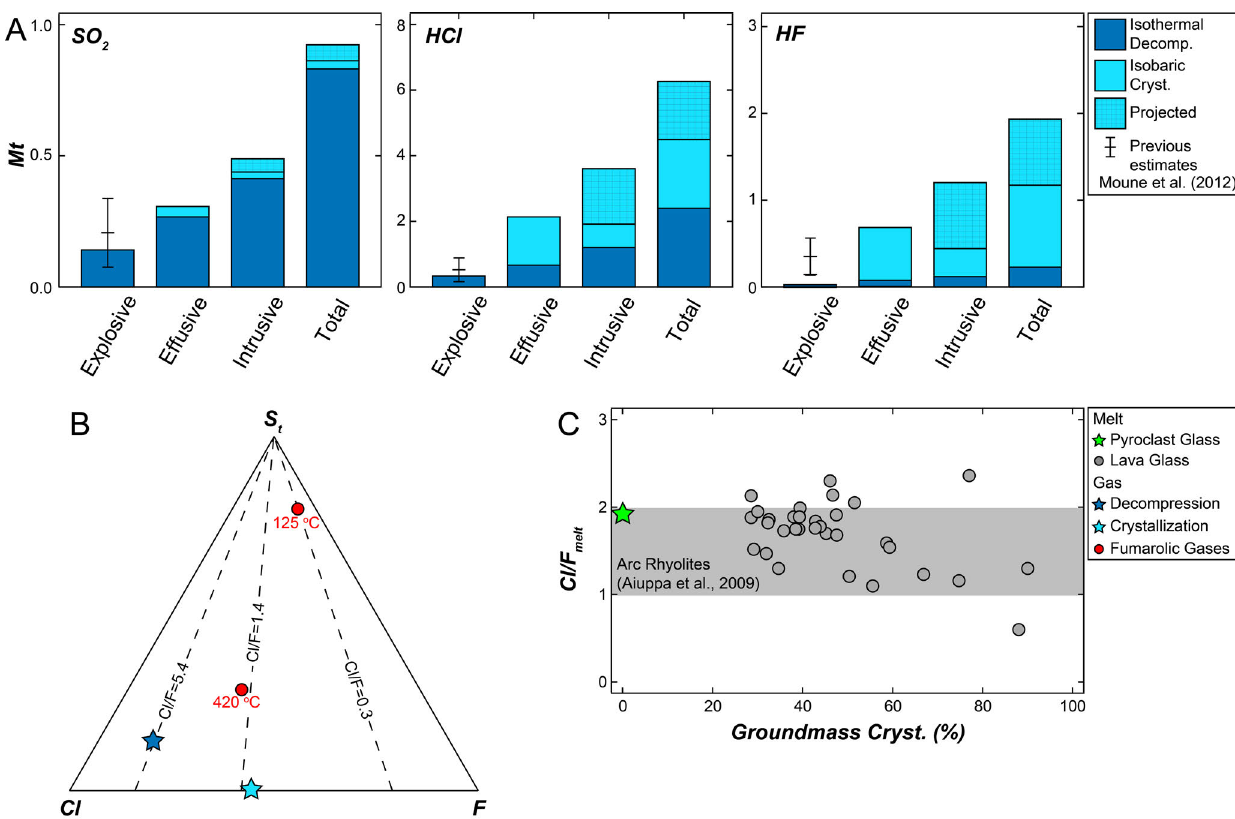
Figure 8: Volatile budget and temporal trends. [A] Histograms of SO , HCl, and HF output (in megatons) during 2 di ff erent phases of the Cordón Caulle eruption, divided into amounts released during isothermal decompression and to-date and projected amounts from isobaric crystallisation. Previous estimates of volatile output for the opening Plinian phase are from Moune et al. [2012]. [B] Relative molar proportions of S, Cl, and F in gases. Stars represent the petrologically-determined gas compositions for decompression and crystallisation. Note that gas released by isobaric crystallisation has equivalent Cl/F to that measured in the 420 ◦ C fumarole (Cl/F ∼ 1.4), but that both fumaroles have higher-than-predicted proportions of S. [C] Evolution of Cl/F in the melt versus degree of groundmass crystallisation, showing that Cl is lost earlier than F in the crystallisation